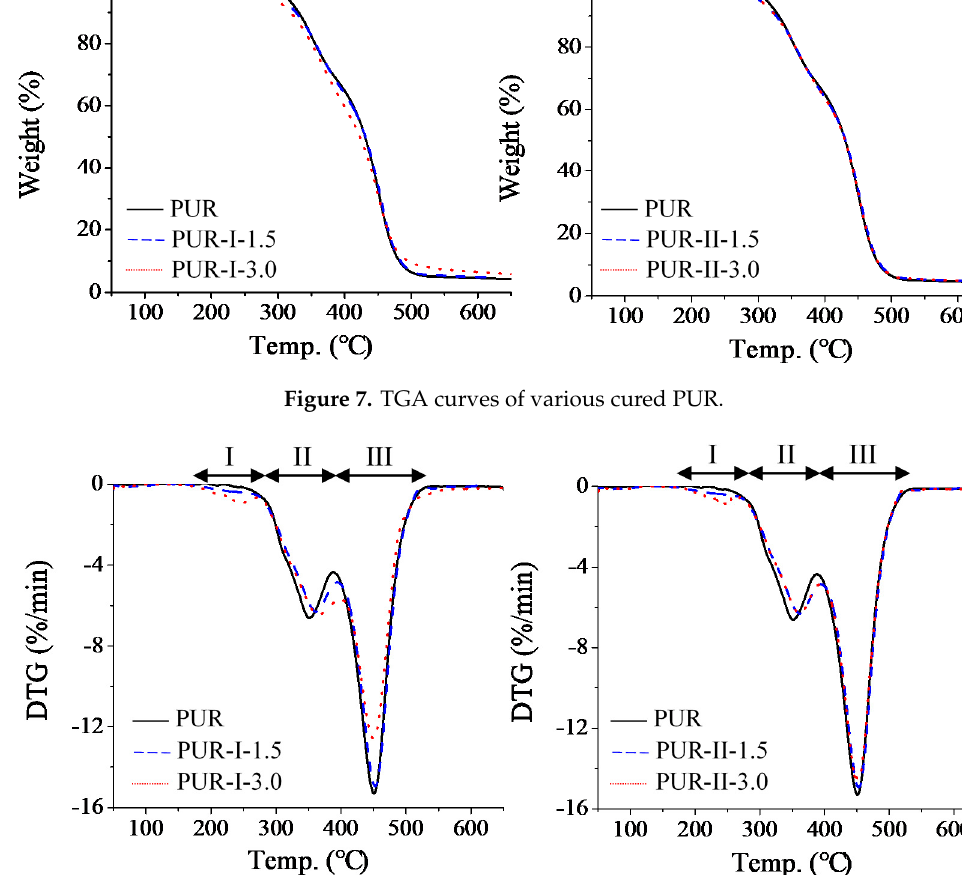
Figure 8. DTG curves of various cured Figure 8 . DTG curves of various cured PUR. Figure 8 . DTG curves of various cured PUR. Table 2 . TGA parameters and mechanical properties of various PUR. Table 2 . TGA parameters and mechanical properties of various PUR.